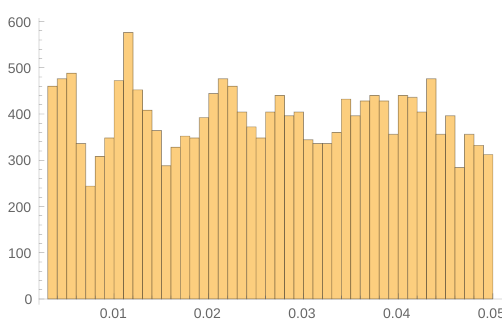
Figure 4 . Distribution for small g s with L =